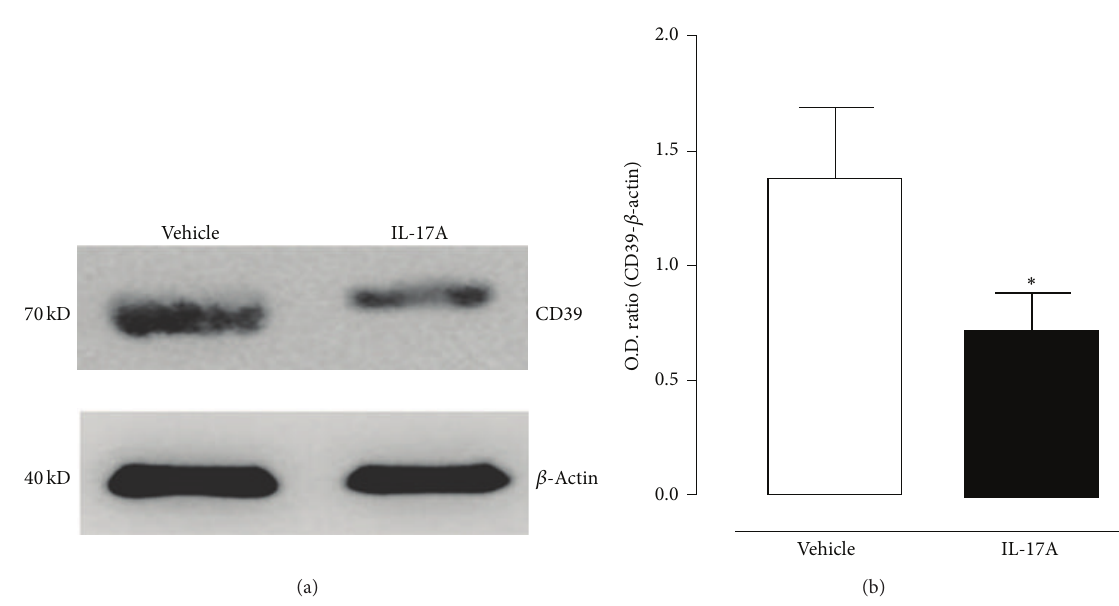
Figure 3: (a) Representative results of Western blot analyses of CD39 expression on rat carotids treated for 30 minutes with vehicle or IL-17A. (b) Densitometric analysis of Western blots; O.D. (optical density) normalized against 𝛽 -actin. ∗ 𝑃 < 0.05 versus vehicle (Student’s t -test; 𝑛 = 3